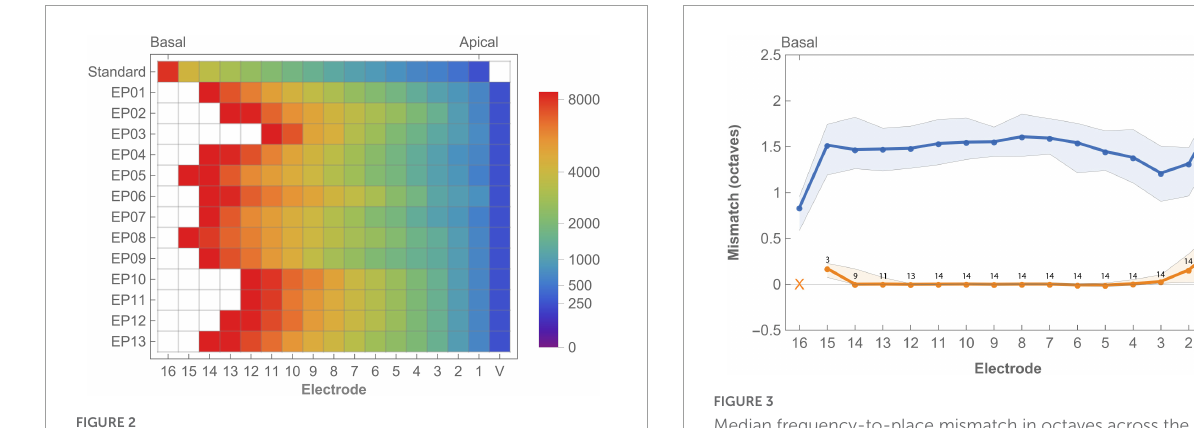
FIGURE2 Standard frequency allocation table and individual imaging-based frequency distribution showing the lower frequency bounds for each electrode. Color coding shows frequency allocation for each electrode. White cells indicate disabled electrodes. V, virtual channel.